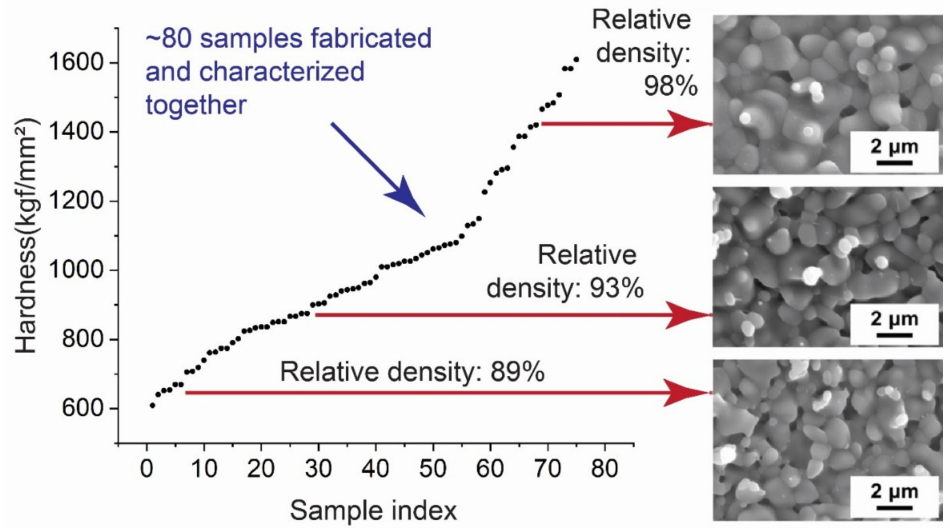
Figure 8. The sample units were continuously varying, showing a wide range of values of hardness and